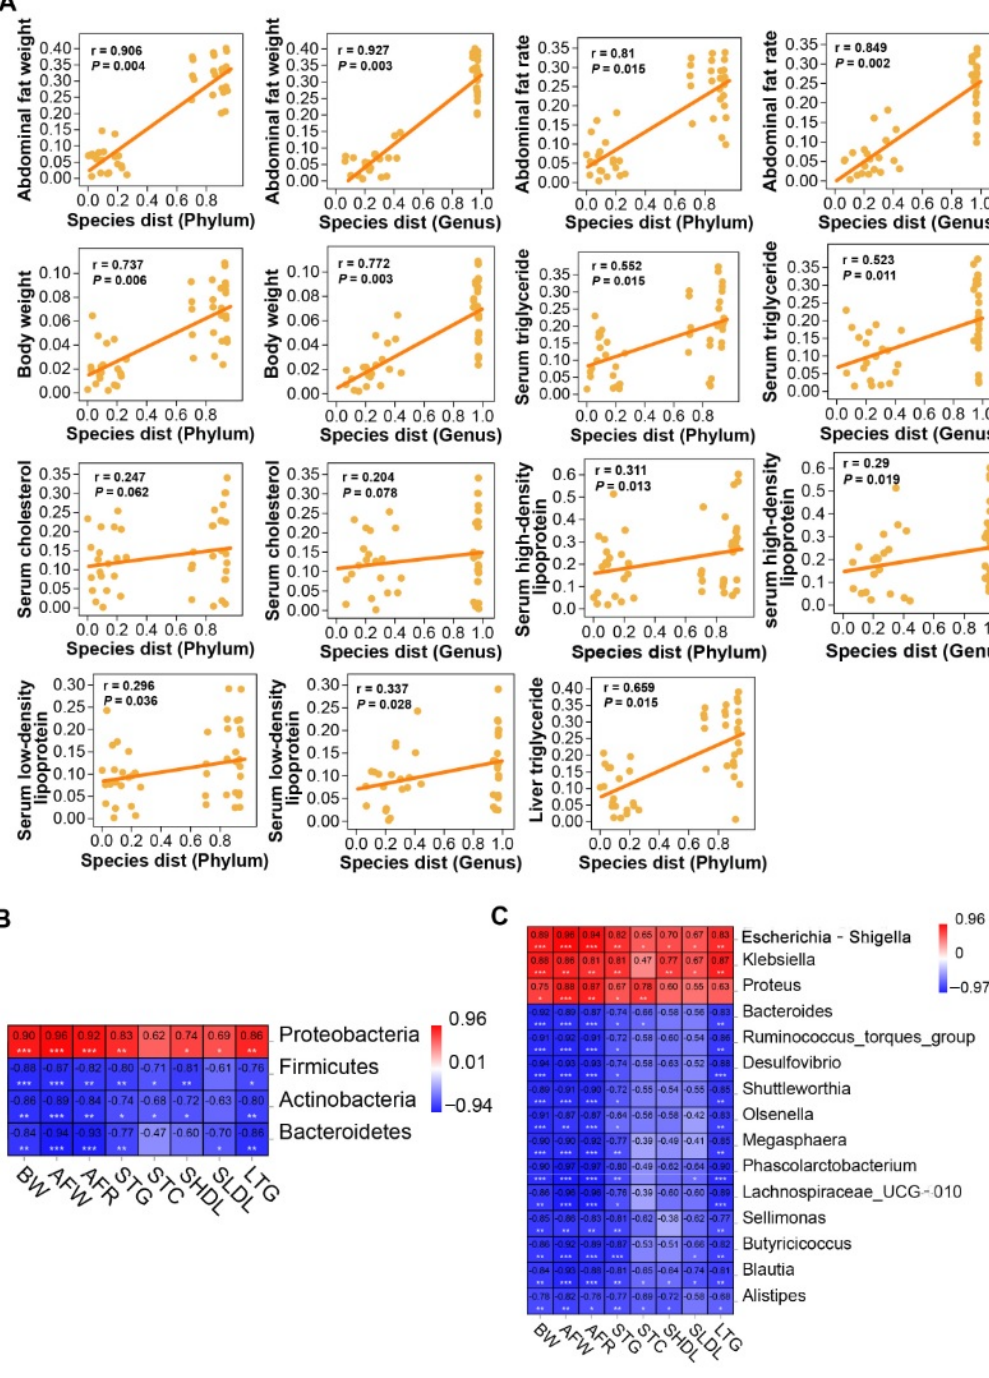
Figure 6. Association between cecal microbiota and lipogenesis. ( A ) Association between species abundance matrix (phylum and genus levels) and lipogenesis indicators. p < 0.05 represents significant difference, p < 0.01 represents highly significant difference. ( B ) Heatmap of correlation between differential phyla and lipogenesis indicators. ( C ) Heatmap of correlation between differential genera and lipogenesis indicators. * p < 0.05, ** p < 0.01. *** p < 0.001. The red and blue colours indicate positive and negative correlation, respectively. NFD ( n = 5), NFDA ( n =